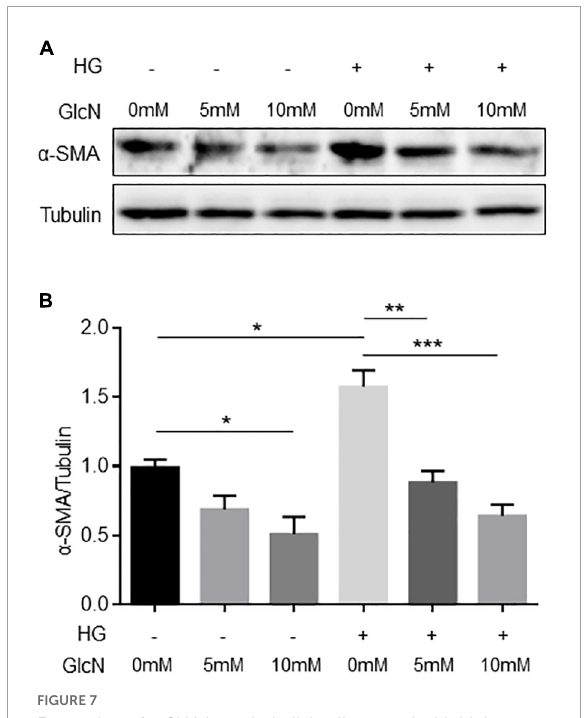
FIGURE7 Expression of α -SMA in endothelial cells treated with high glucose and glucosamine. (A) A representative immunoblot is shown. (B) Expression of α -SMA was quantified using ImageJ. γ -tubulin served as loading control. Data are shown